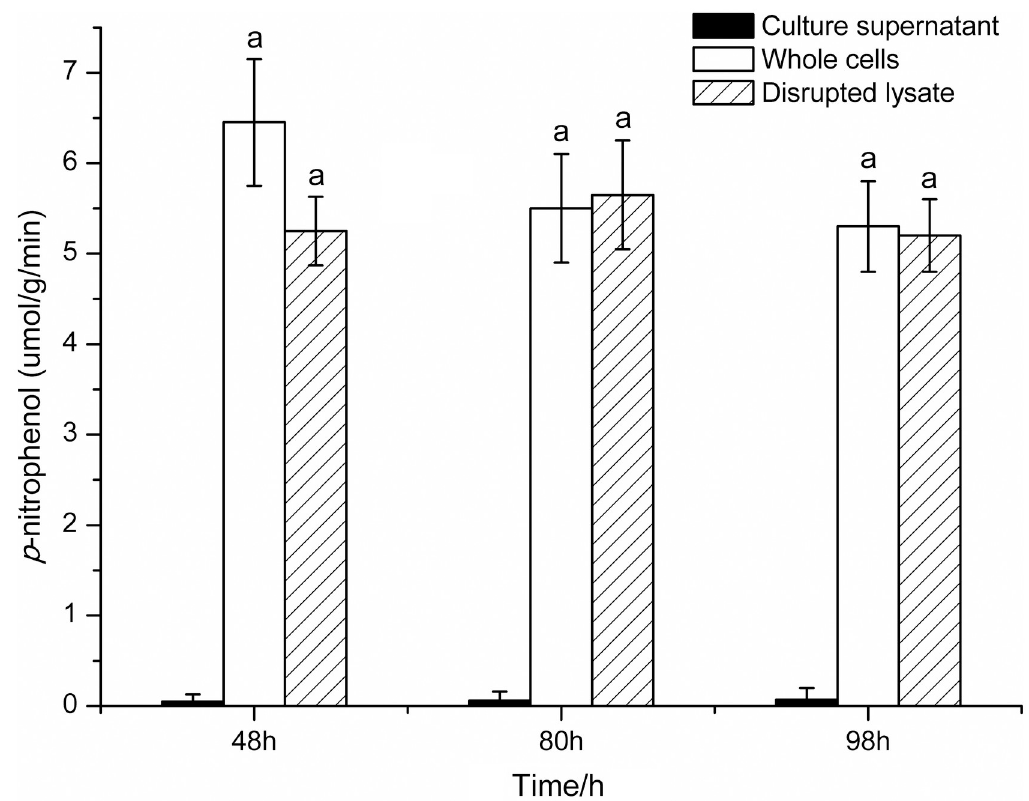
Fig 1. β -D-glucosidase activities of O . oeni SD-2a at different growth phases.